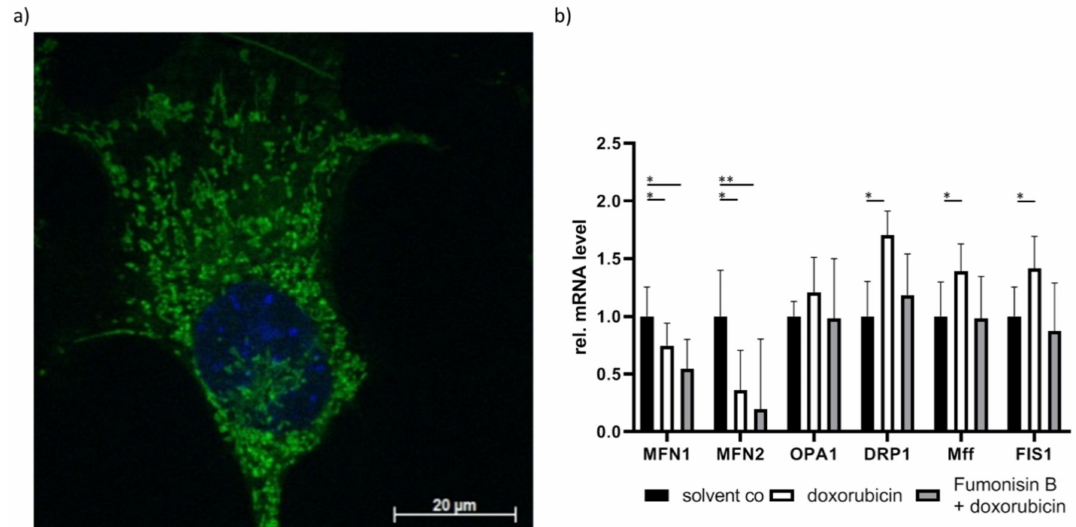
Figure 3. Visualization of mitochondrial structure. ( a ) Impaired and disturbed mitochondrial distribution was stained with MitoTracker (green) and visualized with laser scanning microscopy in doxorubicin-treated HL-1 murine cardiomyocytes. Nucleus was stained with Hoechst (blue). ( b ) mRNA expression of mitochondrial fusion and fission-related genes. Cardiac cell line HL-1 cells treated with doxorubicin showed decreased MFN1 and MFN2 expression but increased DRP1, Mff, and FIS1 expression. Doxorubicin-dependent induction of ceramide level was attenuated upon treatment with the unspecific CerS inhibitor fumonisin B. The fission-related mRNA expression (DRP1, Mff, FIS1) returned to non-significant levels following fumonisin B treatment. Significance was calculated with t -test. * p < 0.05, ** p <